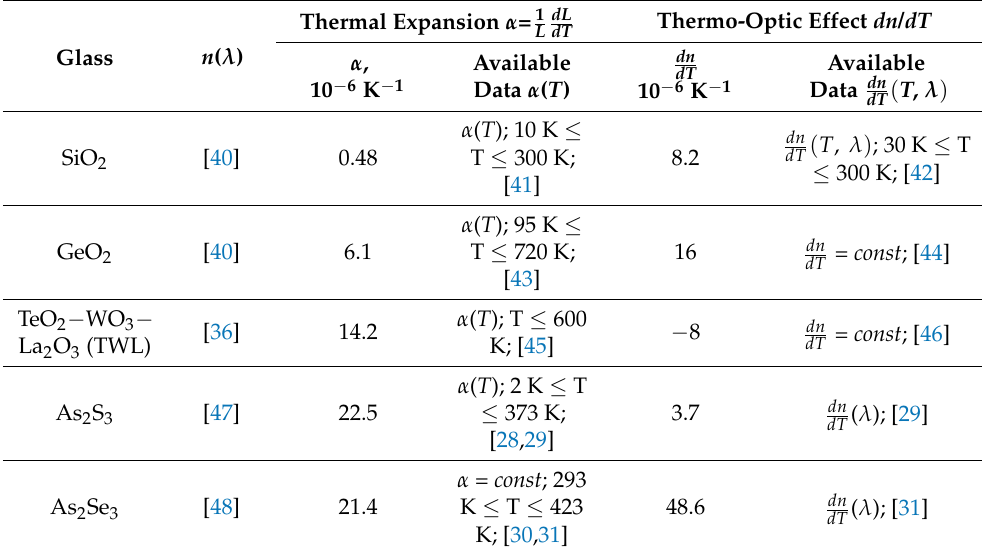
Table 1. Glass parameters from the literature used in simulations. Numerical values are given at room temperature T 0 = 293 K and at light wavelength λ = 1.55 µ